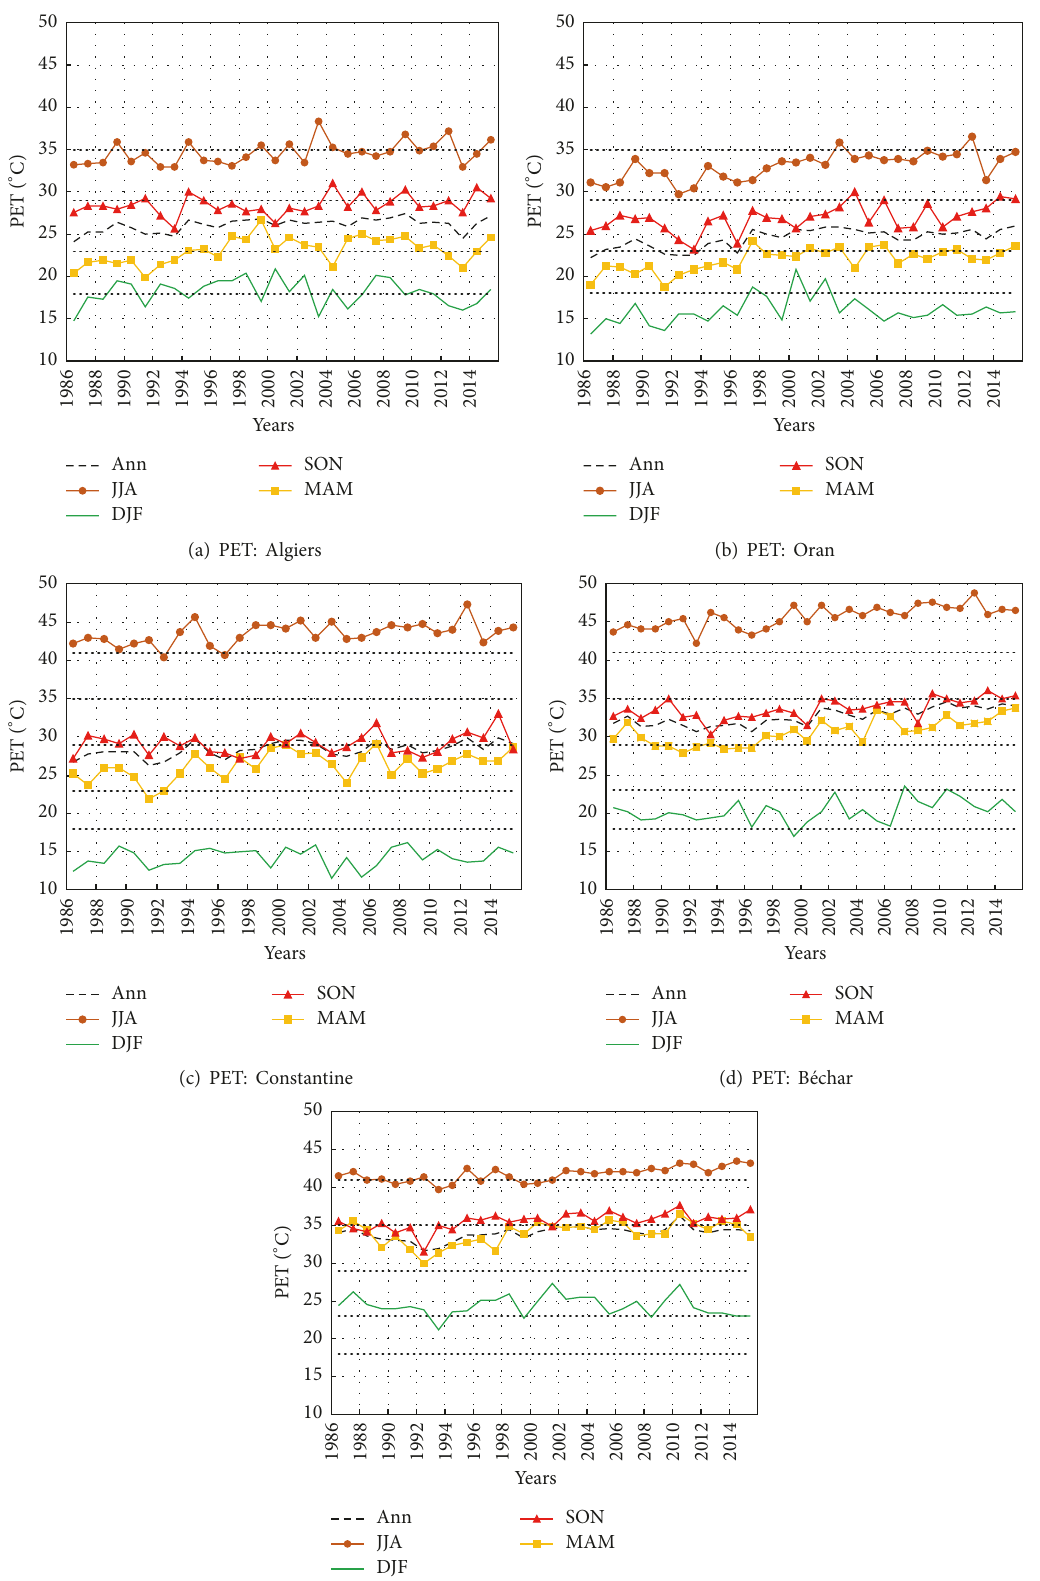
Figure 3: Annual and seasonal evolution time series of PET for the 5 Algerian cities for the period of 1986–2015: “Ann” (dashed curve line) is the annual PET variation, “DJF” concerns the winter season (December to February), “MAM” concerns the spring (March to May), “JJA” concerns the summer (June to August), and “SON” concerns the autumn (September to November). Horizontal straight dotted lines indicate the PET limit thresholds classes mentioned in Table